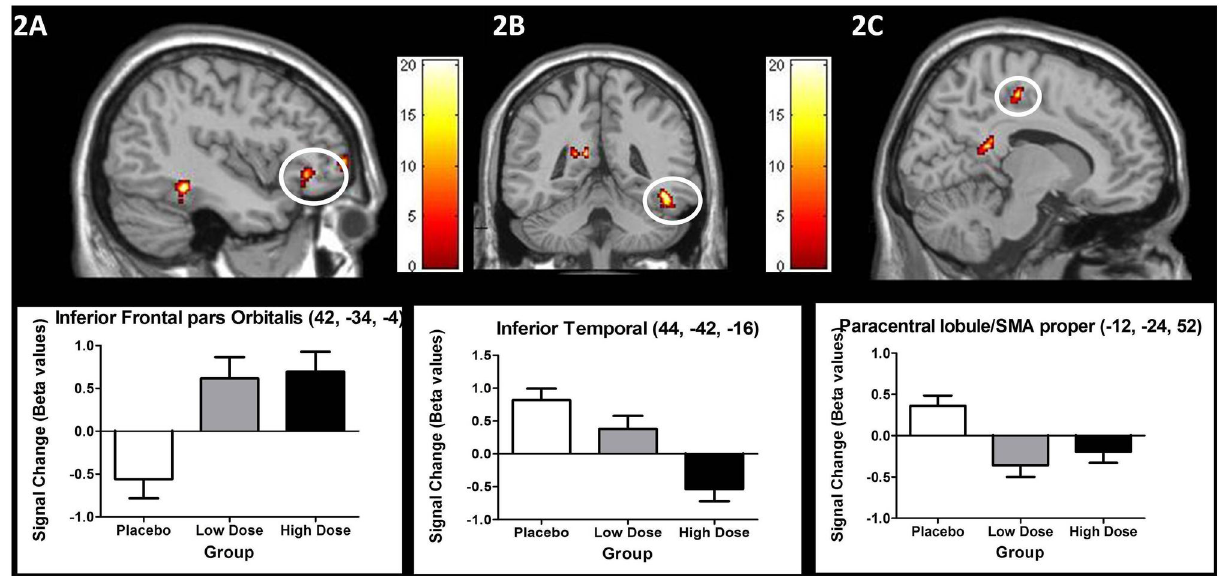
Figure 2. Activations reflecting the main effect of group from the one-way ANOVA Sstop>Go 2 nd -level model (thresholded at p < 0.005, k = 13; scale represents F statistic; see results section for details). Linear increases were found in inferior frontal gyrus pars orbitalis (Figure 2A), while linear reductions were observed in an inferior temporal cluster (Figure 2B). Non-linear, overall reduction in activation following both doses of alcohol was observed in SMA proper (Figure